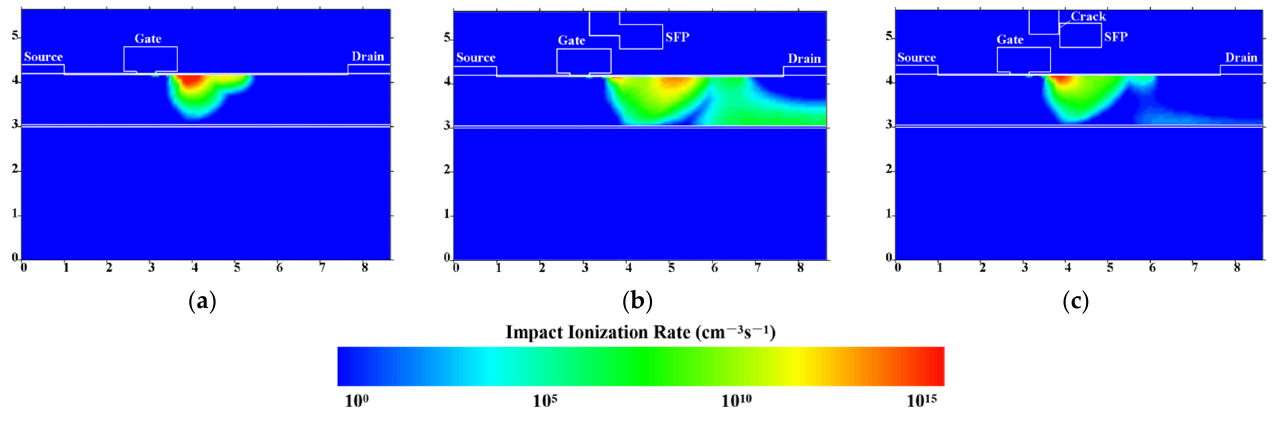
Figure 4. Impact ionization rate contours for AlGaN/GaN HEMT ( a ) without an SFP; ( b ) with a conventional SFP; ( c ) with a 20 nm wide cracked SFP at their respective V br points. The potential distributions for the three different aforementioned AlGaN/GaN HEMT structures were simulated at V g = − 6 V and V d = 160 V. The contours for a closeup region, including the gate and SFP, are shown in Figure 5. It was observed that for the HEMT without an SFP, most of the potential lines crowded at the drain side of the gate, as well as in the barrier and buffer layers. Crowded potential lines usually lead to a high electric field and consequently a high impact ionization rate. For the HEMT with a con- ventional SFP, high potential line density appeared at both the drain side of the gate and the drain side of the SFP, which is attributed to the modulation effect of the SFP [12,26,27]. The potential line densities in the barrier and buffer layers were also lower than those for the HEMT without an SFP. Once the SFP had cracked, some potential lines appeared in the cracked region. The right part of the SFP did not share the same potential as the left part anymore, and its modulation effect finally weakened.